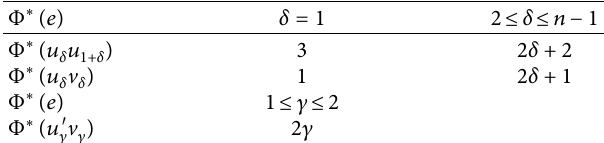
Table 26: Edge labeling of Φ ∗ ( e ) .